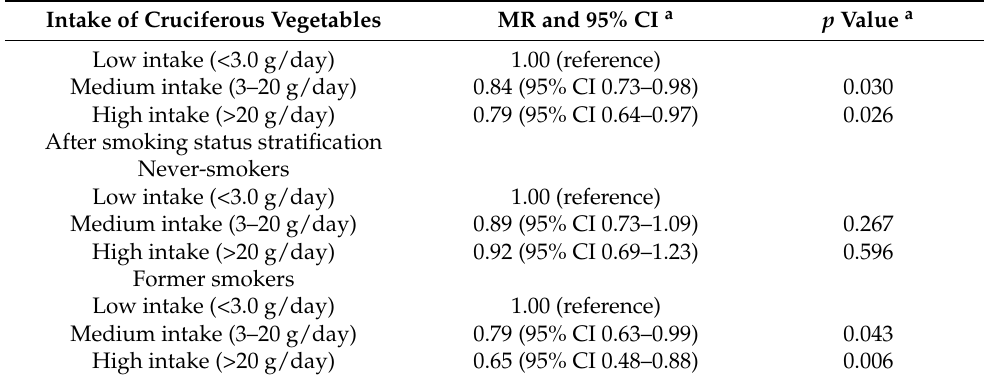
Table 4. Mean Ratio (MR) of DNA adducts and 95% Confidence Interval (CI) by dietary categories and smoking